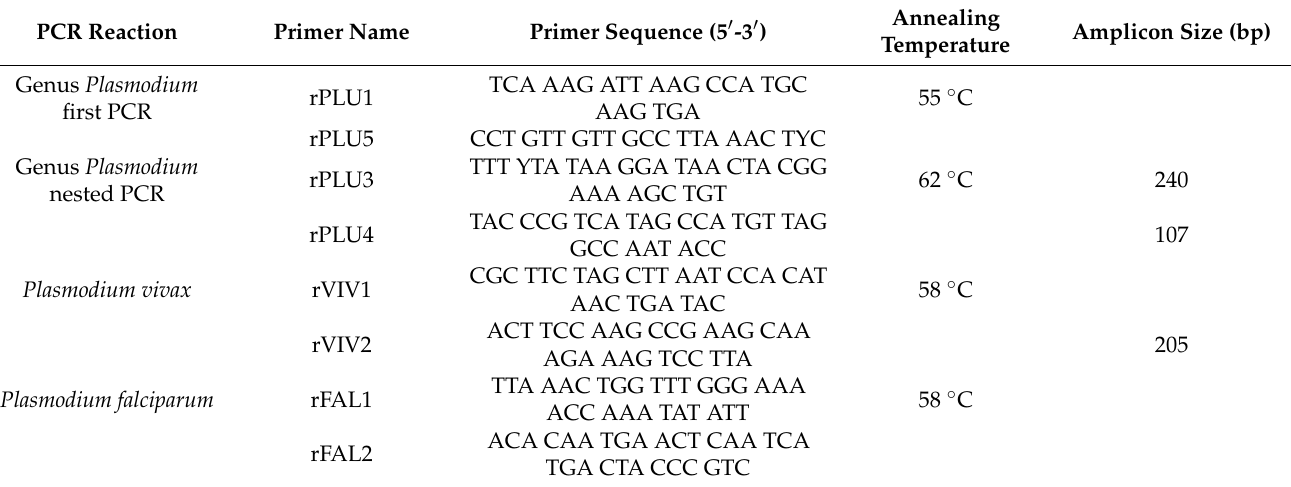
Table 1. Primers and PCR conditions used for Plasmodium